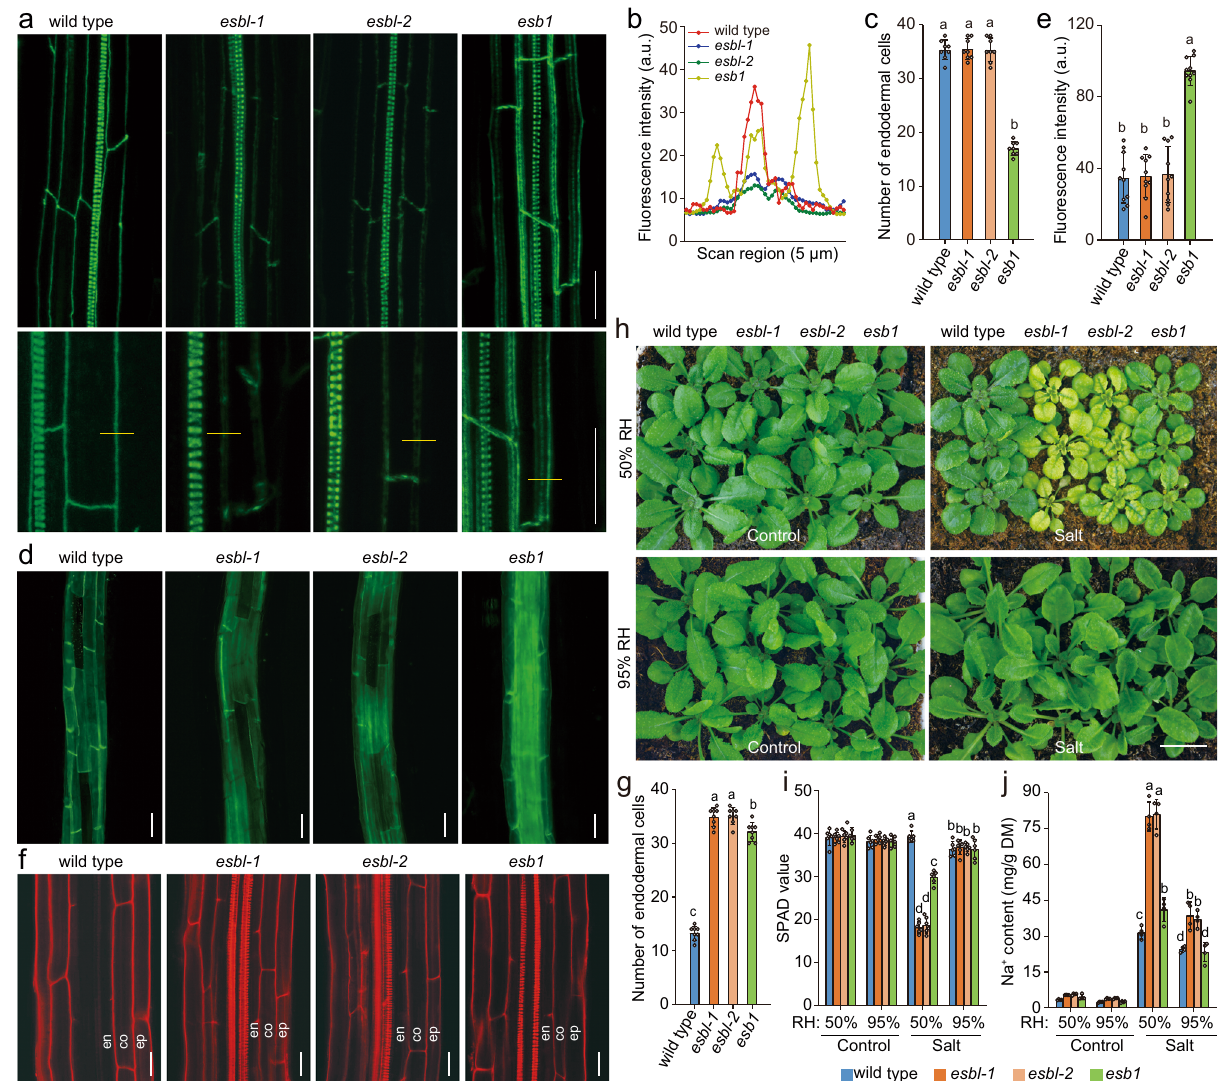
Fig. 6 Arabidopsis ESBL is essential for CS development and salt tolerance under high transpiring condition. a Confocal z-projections of endodermal Casparian strip auto fl uorescence. b The intensities and pattern of the CS auto fl uorescence in the indicated genotypes. The measurements were conducted at the locations indicated by the yellow lines in ( a ). a.u., arbitrary units. c – e Fluorescence assay of endodermal suberin deposition using fl uorol yellow 088 staining. The results showed the locations where the endodermal suberin deposition start ( c ), the pattern ( d ) and intensities ( e ) of fl uorescence in the indicated samples. f – g PI penetration-based assay of the function of endodermal CS barrier. ep, epidermis; co, cortex, en, endodermis. Quanti fi cation in ( c ) and ( g ) was done by counting endodermal cells after the onset of elongation as described in previous study 2 , and the results were expressed as mean ± SD of 8 roots. The images in ( a , d and f ) were respectively taken at ~25 th , ~40 th and ~25 th endodermal cell after the onset of elongation, and the images were representative of three independent repeats with similar results. h – j The appearances ( h ), SPAD values ( i ) and shoot Na + contents ( j ) of esbl-1 , esbl-2 , esb1 and wild-type plants with the indicated treatments. Plants were grown in standard conditions for 4 weeks, and then watered once to soil saturation with either 150mM NaCl or water (Control). Seven days later, the plants were photographed, the SPAD values of the 4 th leaf were measured, and the shoot Na + contents were determined. The results in ( i ) and ( j ) were means±s.d. of three independent experiments. Bars in ( a , d and f ), 20 μ m; Bars in ( h ), 1cm. Source data are provided as a Source Data fi